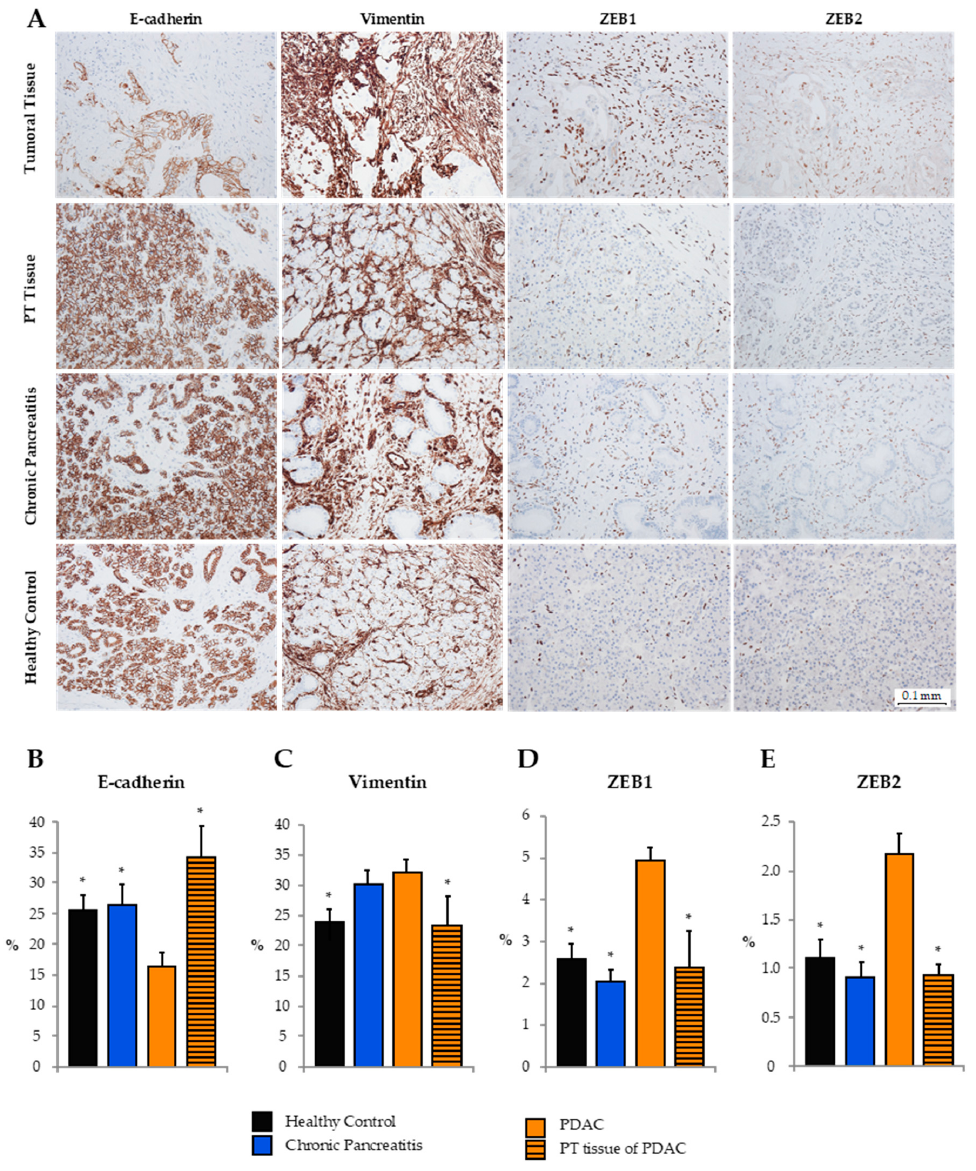
Figure 3. ( A ) Tissue microarray immunohistochemistry of exemplary PDAC, chronic pancreatitis (CP), and healthy clinical tissue samples. Mean expression ± standard error of the mean (SEM) of epithelial-to-mesenchymal transition markers ( B ) E-cadherin, ( C ) Vimentin, ( D ) ZEB1, and ( E ) ZEB2 as assessed by ImageJ. (*) indicates statistically significant differences in expression to PDAC tumor tissue (assumed at p ≤ 0.05, Kruskal–Wallis test). PT, peritumoral.